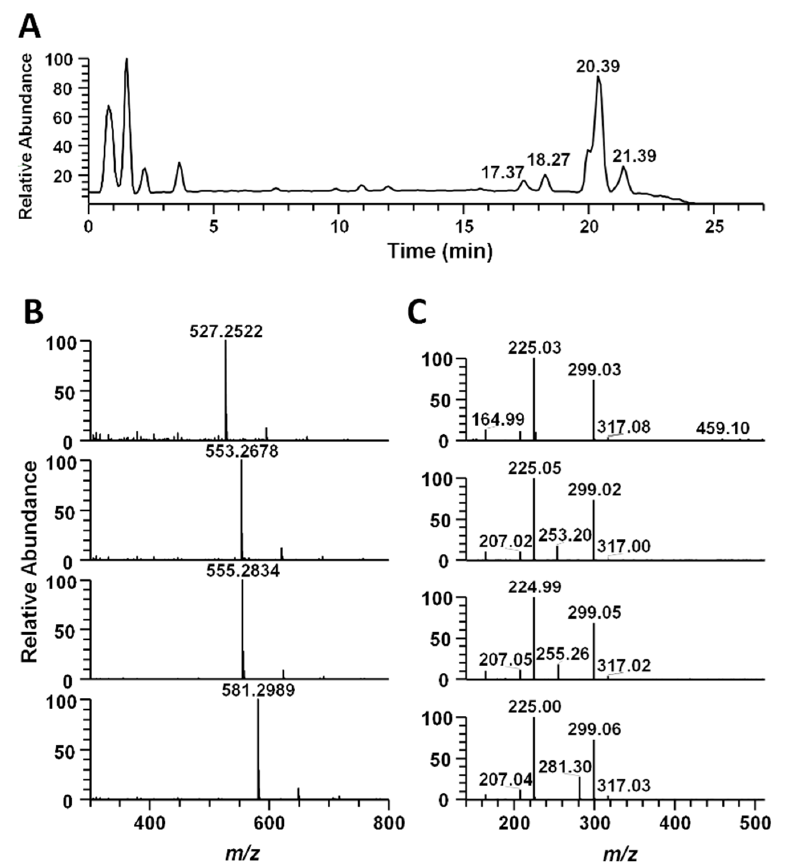
Figure 6. The high-resolution UPLC-MS/MS result of ethanol extract of marine brown alga S. horneri . ( A ) Mass chromatogram of the ethanol extract at negative ion mode. ( B ) High-resolution mass spectrum of 4 sulfoglycolipid compounds at retention times 17.37, 18.27, 20.39 and 21.39 min. ( C ) Tandem mass spectrum of each of the 4 sulfoglycolipid compounds ( m / z 527.2522, 553.2678, 555.5834 and 581.2989).